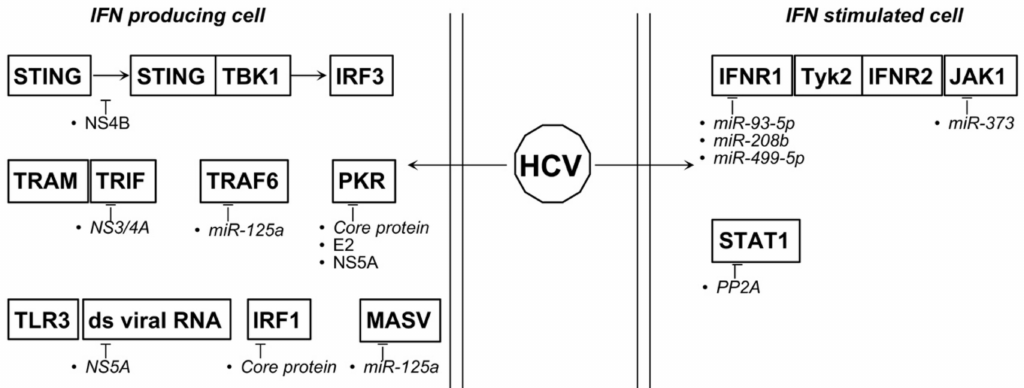
Figure 7. Proteins and miRNAs able to deregulate type I IFNs relevant pathways during HCV associated tumorigenesis. Italics represent indirect action.